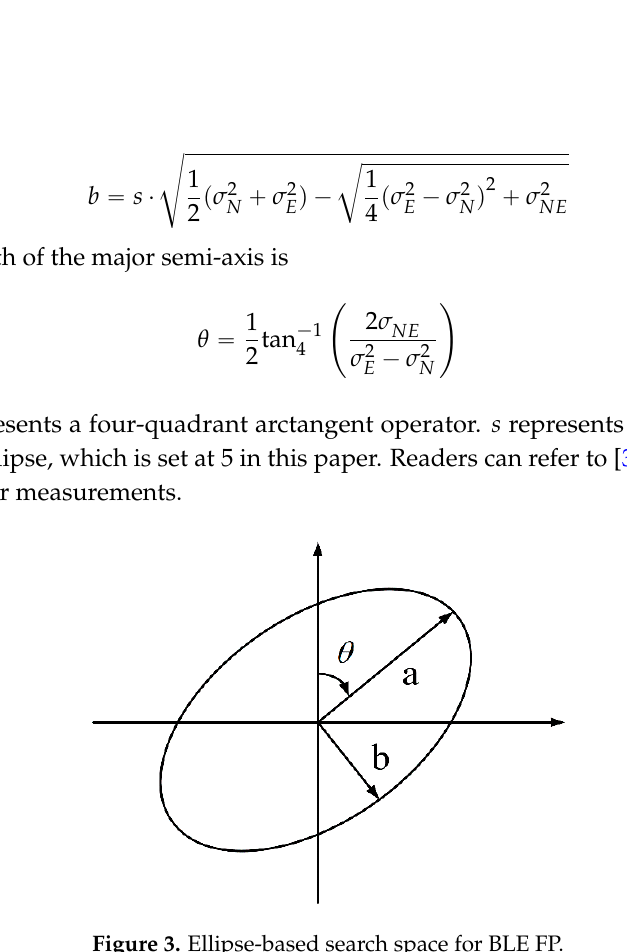
Figure 3. Ellipse-based search space for BLE FP.